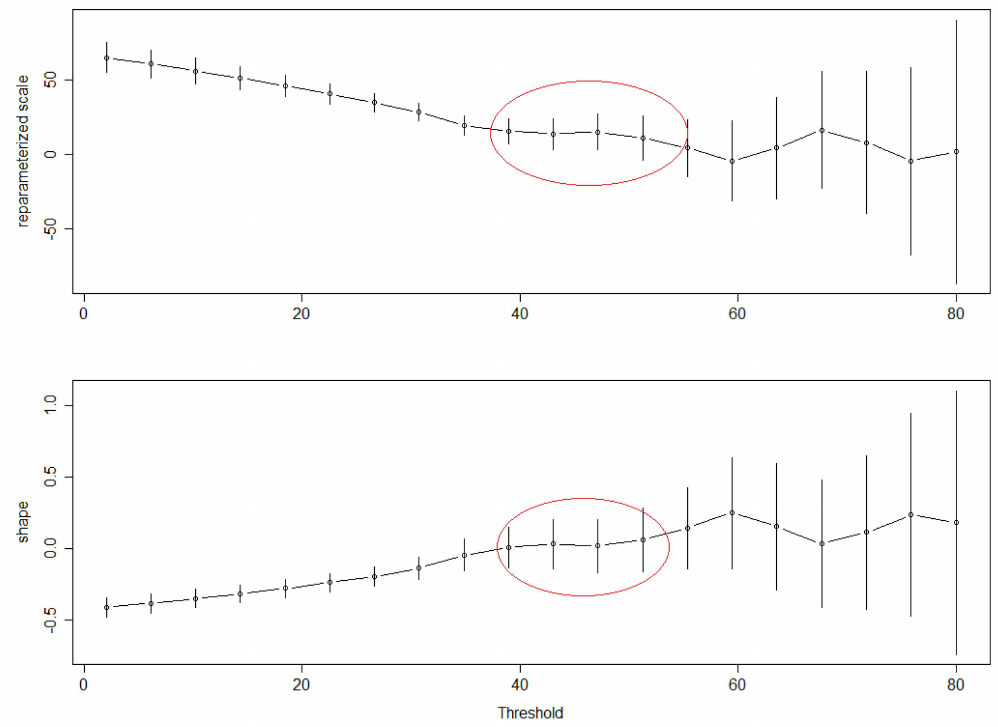
Figure A2. Parameter estimates against threshold for daily rainfall data at Bonou station (first